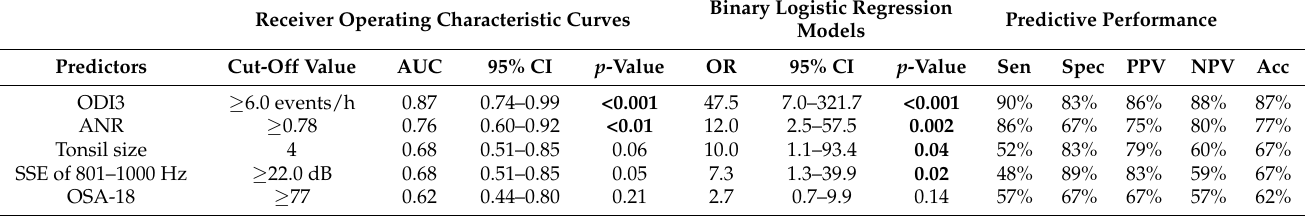
Table 3. Clinical variables as potential predictors of severe OSA in Study 1.